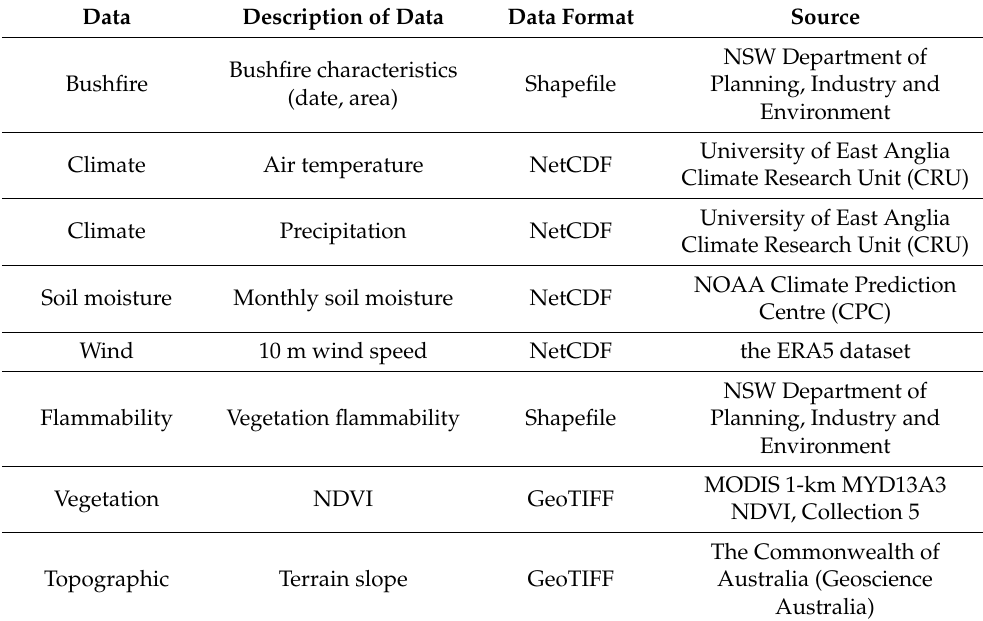
Table 1. The data of bushfire and its drivers used in this study.